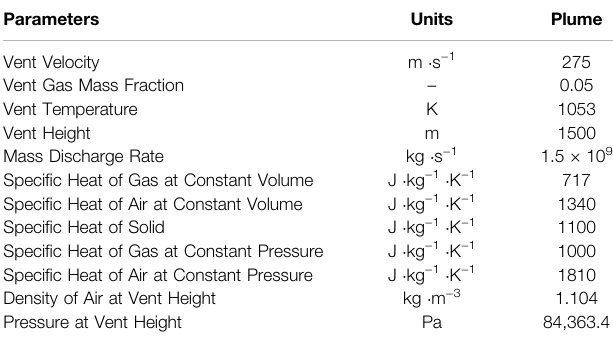
TABLE 1 | List of eruption condition and material properties for plume simulation. Parameters